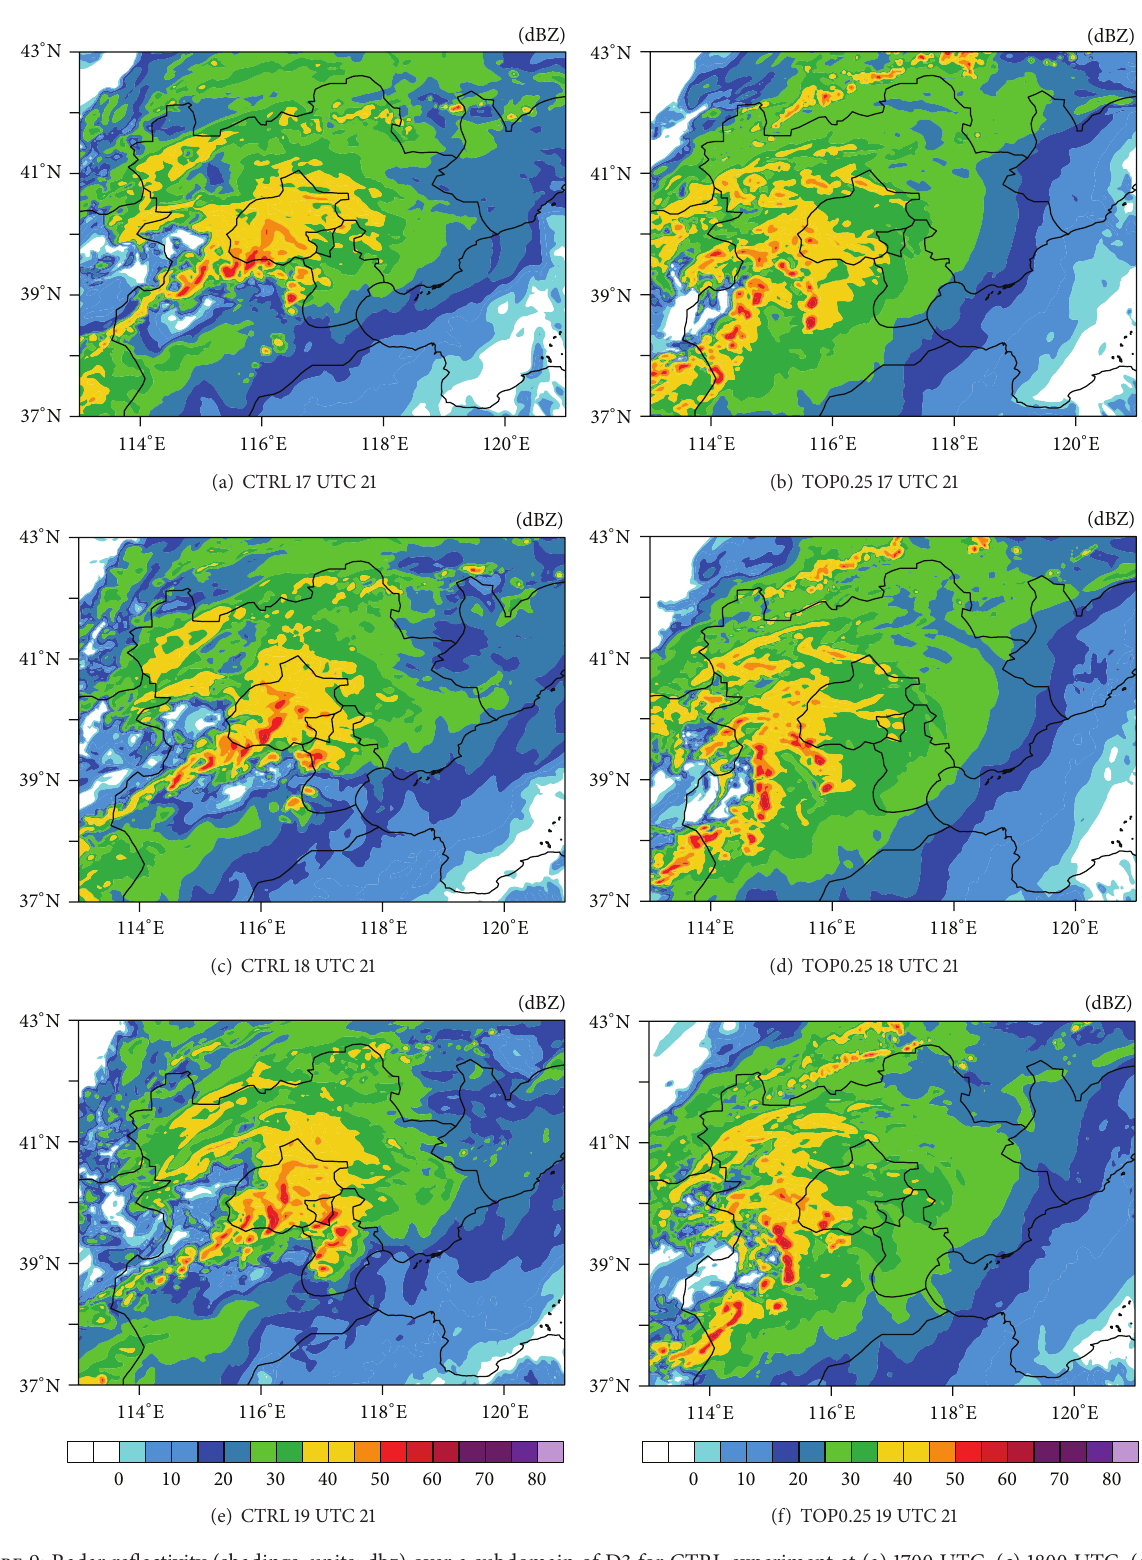
Figure 9: Radar reflectivity (shadings, units: dbz) over a subdomain of D3 for CTRL experiment at (a) 1700 UTC, (c) 1800 UTC, (e) 1900 UTC JUL2012. (b), (d), and (f) as in (a), (c) and (e), respectively, but for the TOP0.25